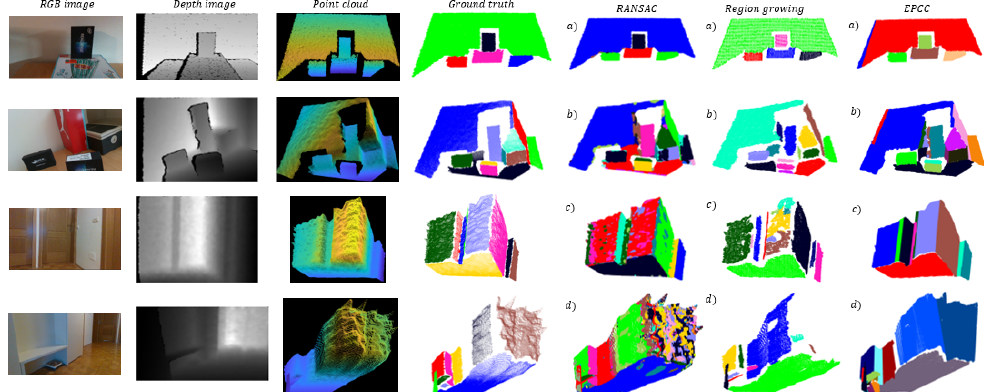
Figure 21. Planar segmentation results, in which individual flat surfaces of a point cloud are color- coded. Clustered region-growing point clouds are more sparse due to required filtering process.